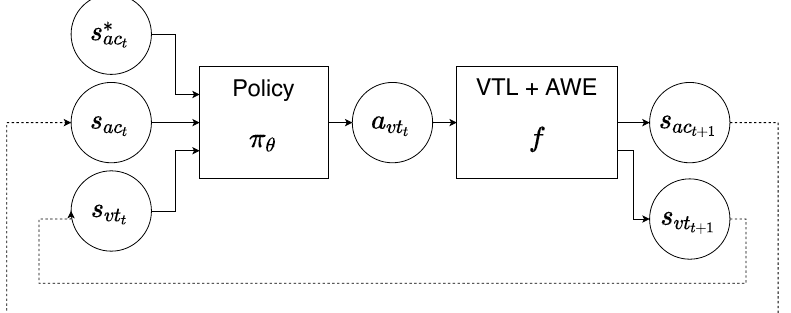
Figure 4. Closed-loop control of articulatory synthesizer for the imitation